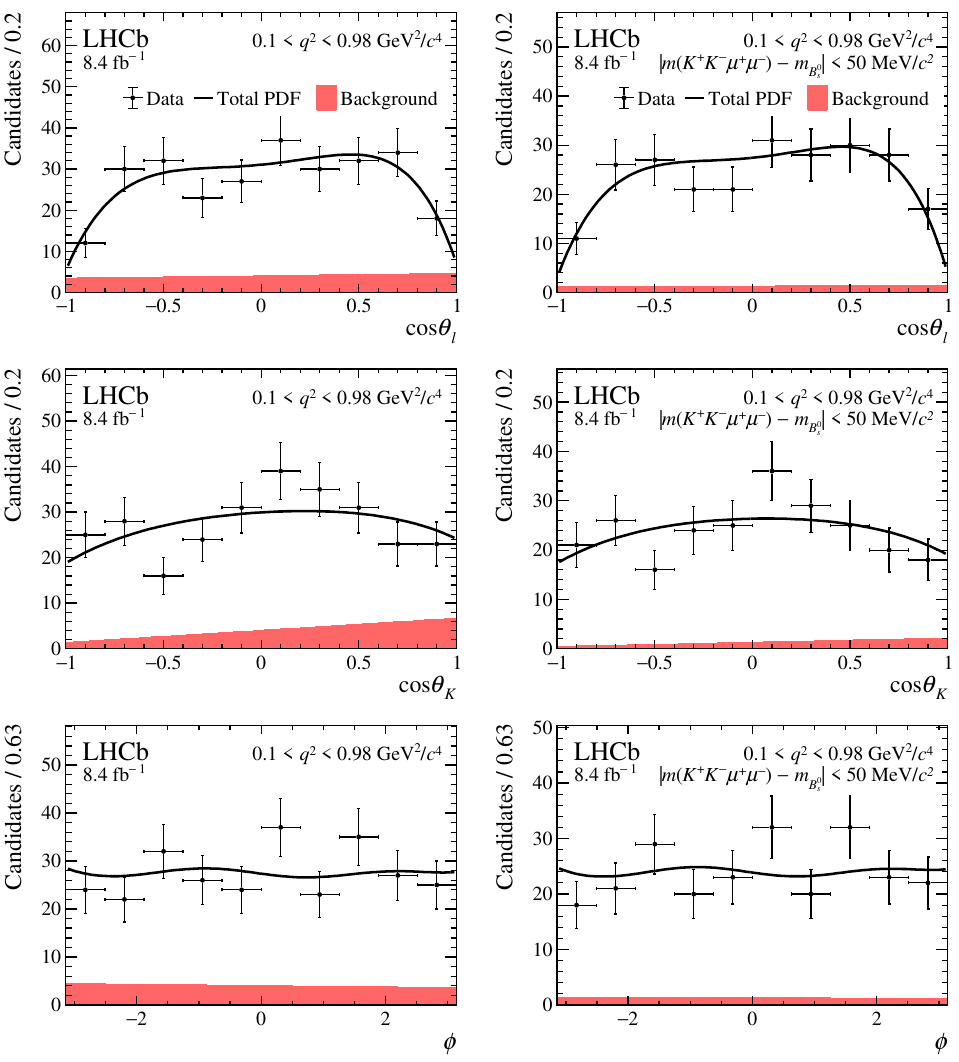
Figure 5 . Projections in the region 0 . 1 < q 2 < 0 . 98 GeV 2 /c 4 for the angular distributions of the the combined PDF. The red shaded area indicates the background component and the solid black line the total PDF. The angular projections are given for candidates in (left) the entire mass region used to determine the observables in this paper and (right) the signal mass window ± 50 MeV/ c 2 around the known B 0 s